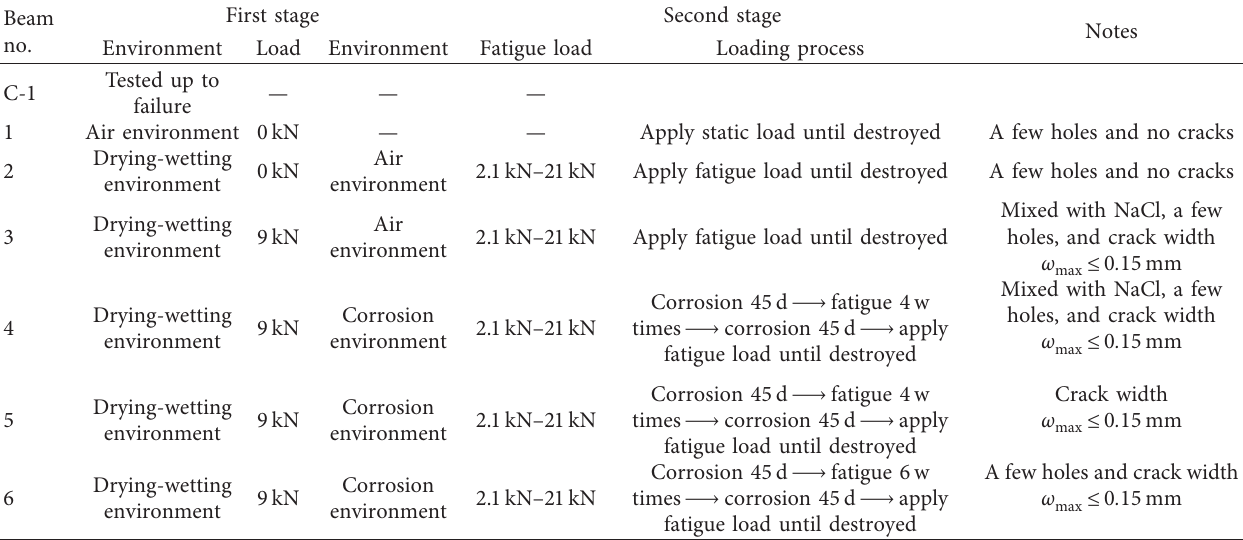
Figure 1: Design drawing of the dimensions of reinforced concrete beam. Table 1: The test results of six